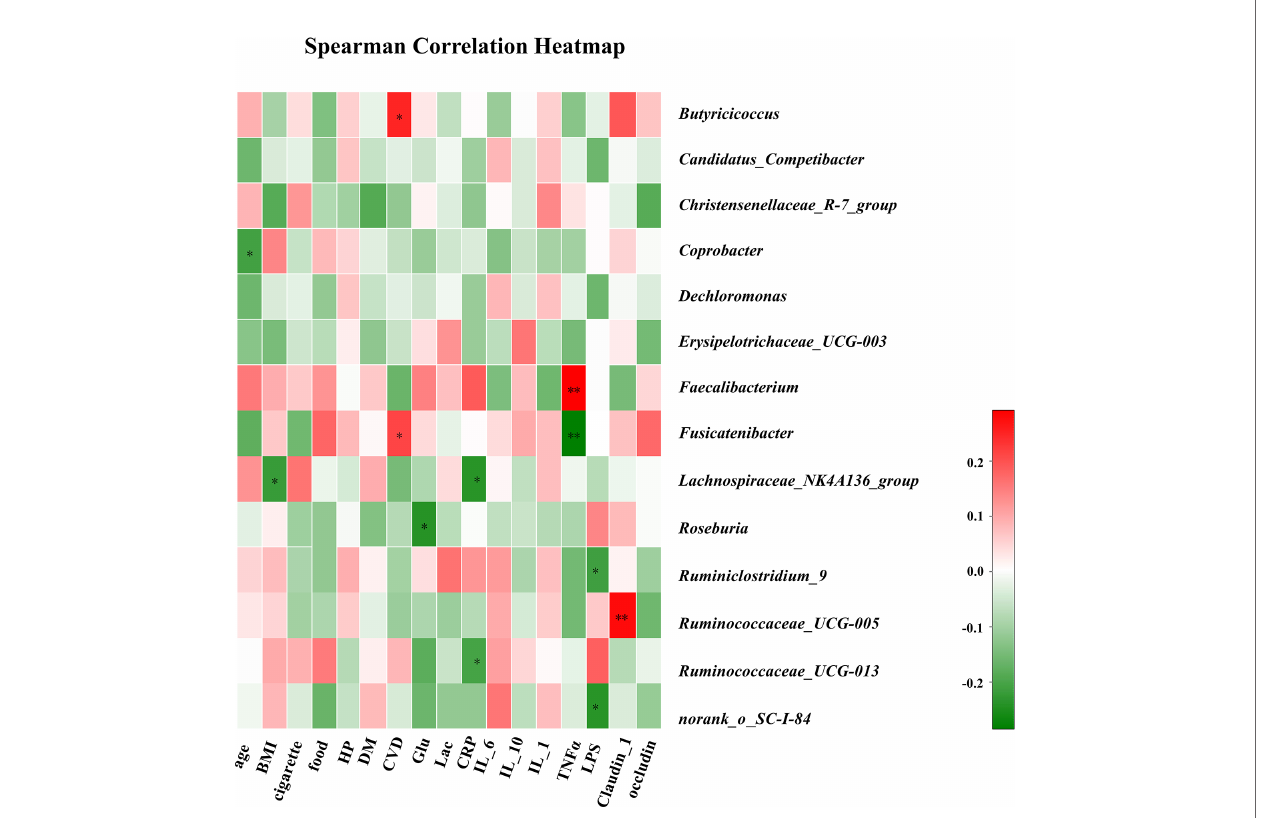
FIGURE 4 | Correlation analysis of clinical parameters and gut microbiota. The association between 17 clinical parameters and signi fi cant bacterial genera with altered abundances among the three groups is estimated using the heat map of Spearman ’ s correlation analysis. Color intensity represents the magnitude of correlation. Red, positive correlations; Green, negative correlations. P-value < 0.05, **P-value < 0.01.